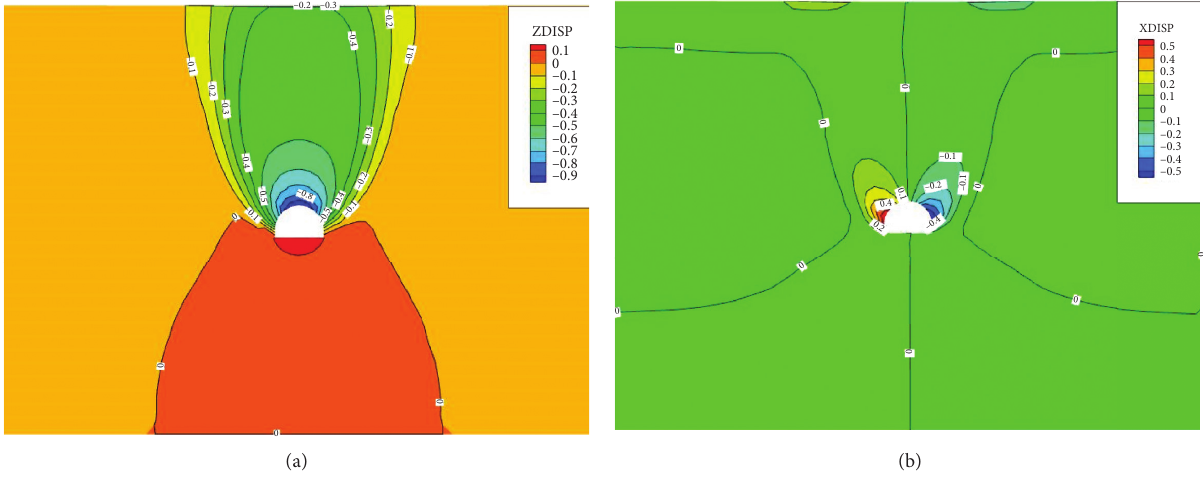
Figure 10: Displacement contour of surrounding rock of tunnel under improved support. (a) Contour of Z -displacement under improved support. (b) Contour of X -displacement under improved